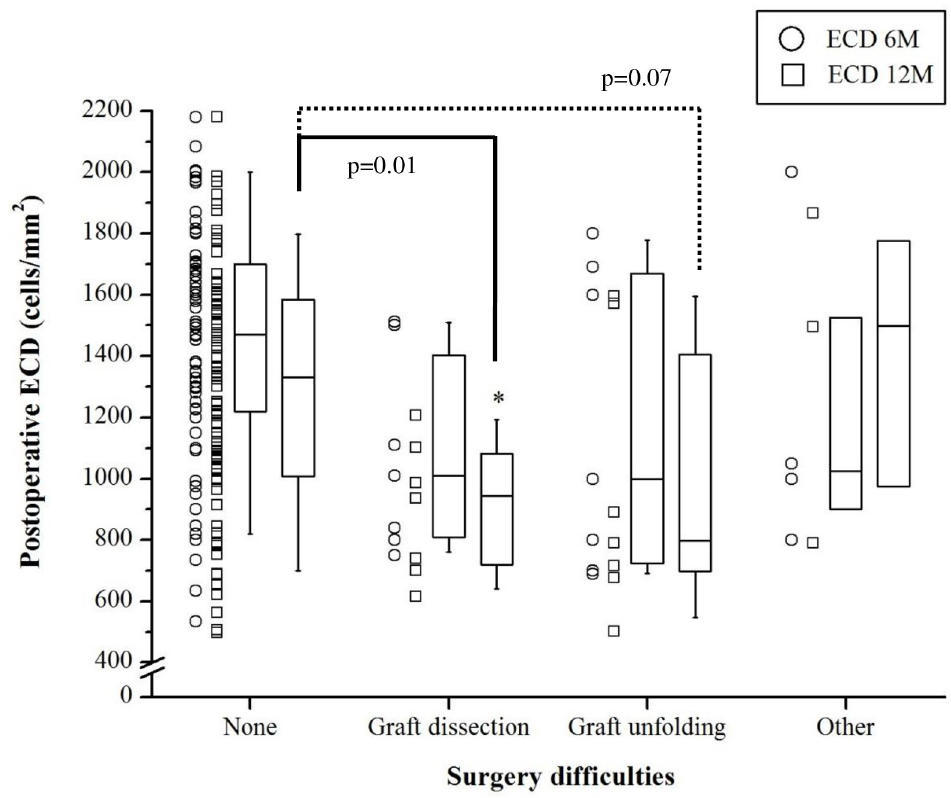
Fig 2. Comparison of surgically difficult and uncomplicated DMEK cases in terms of ECD at 6 and 12 months. The surgically difficult cases were divided according to the type of difficulty (difficult graft preparation, unfolding, or other). The data are presented as box-whisker plots showing the median, first and third quartiles, and maximum and minimum values. Kruskal-Wallis analyses showed that the four groups differed significantly in terms of 12-month ECD (p = 0.03). Mann-Whitney U-tests showed that 12-month ECD was significantly lower in the difficult graft preparation cases (p = 0.01) and tended to be lower in the difficult graft unfolding cases (p = 0.07) compared to the group with no surgery